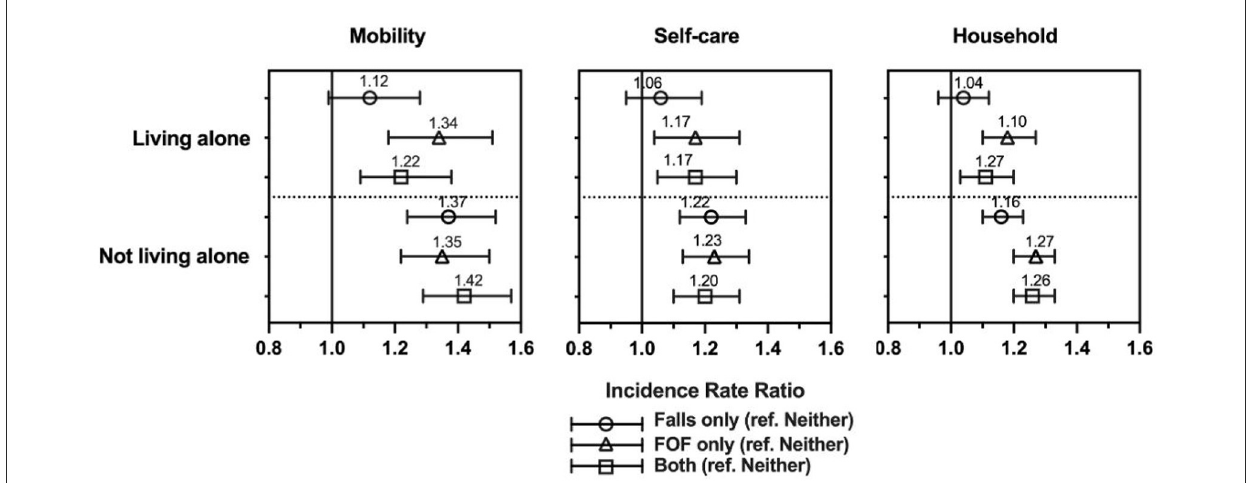
FIGURE2 Association of baseline falls and FOF status and follow-up functional limitations stratified by living arrangement. Models adjusted for sociodemographic factors (age, sex, race/ethnicity, education) and health-related factors (obesity, depressive symptoms, anxiety symptoms, bothersome pain, visual impairment, dementia, hospitalization, number of chronic diseases, and Short Physical Performance Battery) and outcome of interest at baseline. FOF, fear of falling; IRR, incidence rate